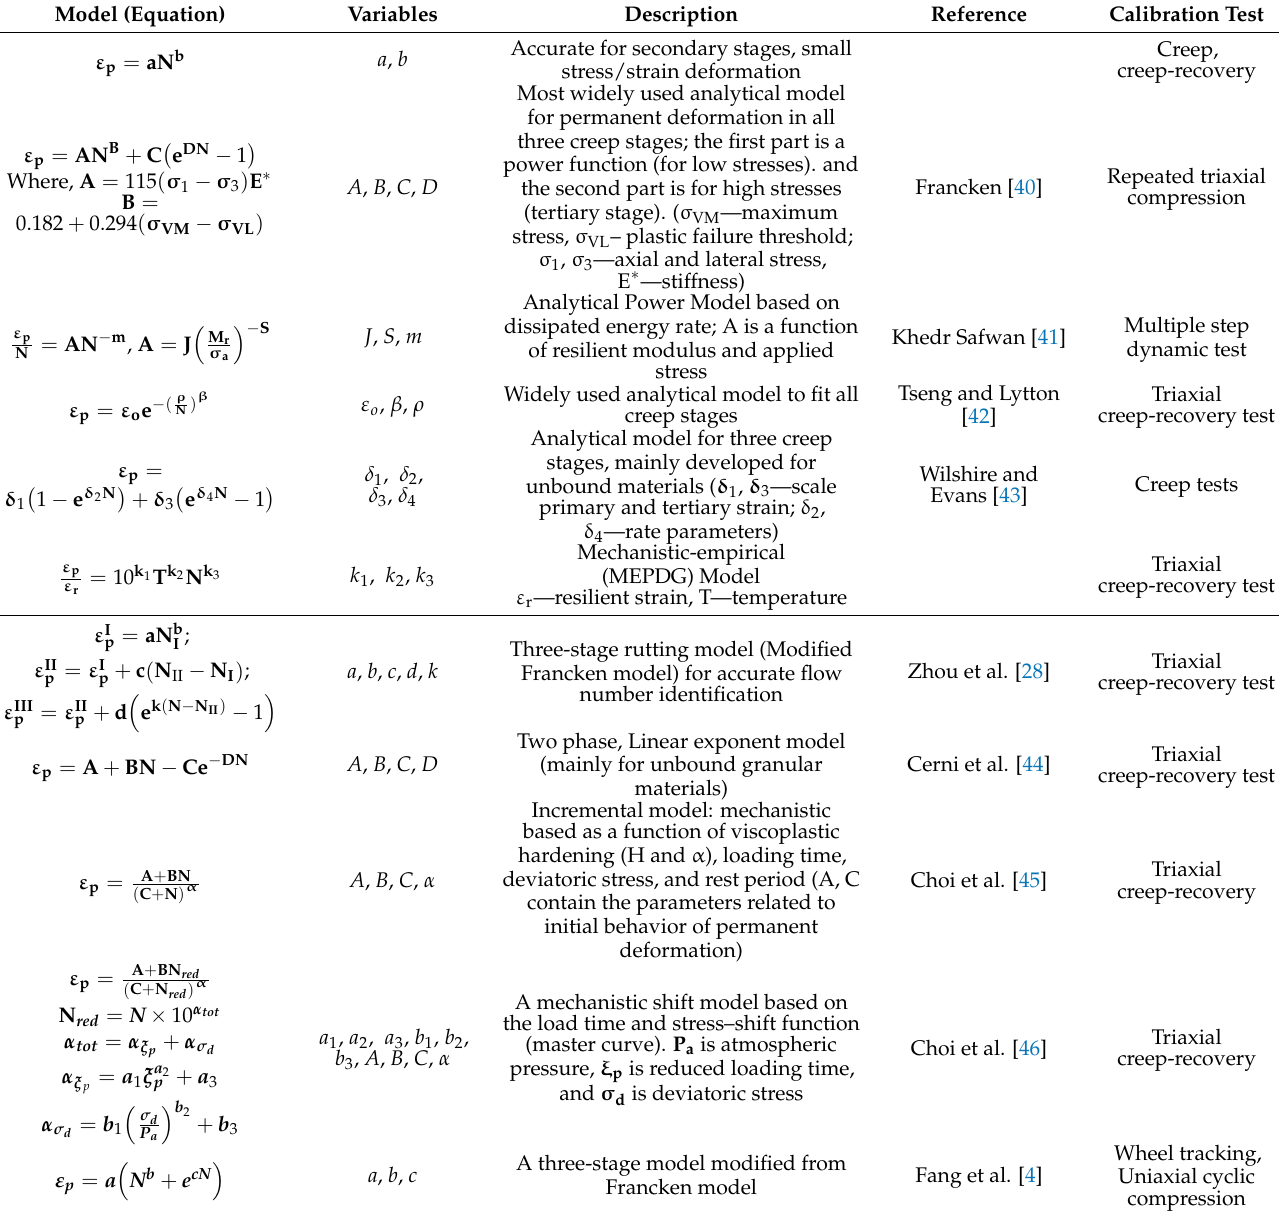
Table 1. Some selected permanent deformation analytical